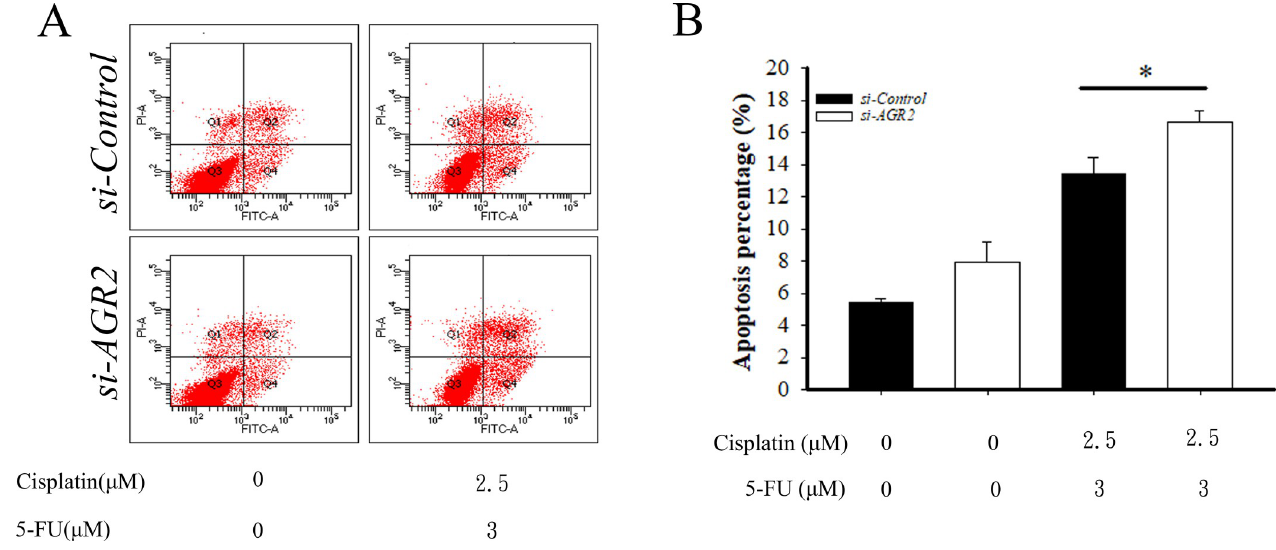
https://doi.org/10.1371/journal.pone.0276990.g006